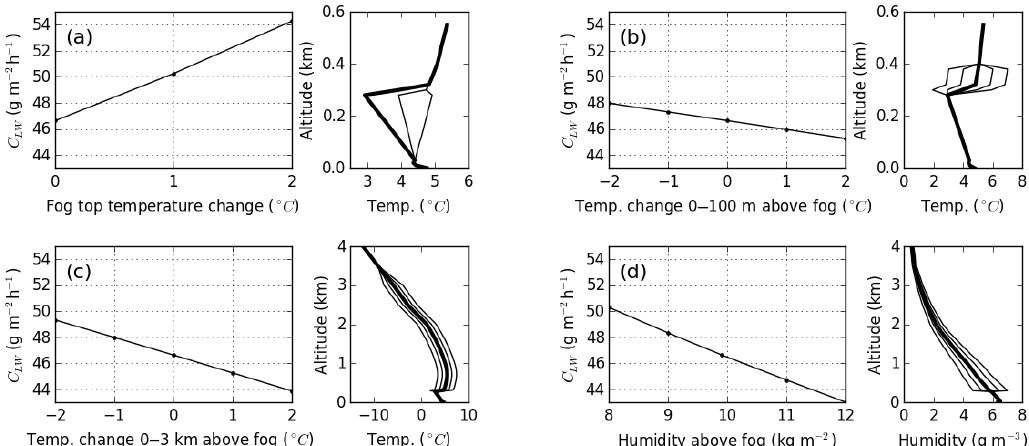
Figure 9. Sensitivity of C LW (defined in Sect. 2.1) to changing the fog top temperature (a) , the temperature in the first 100m above the fog (b) , the temperature in the first 3km above the fog (c) and the humidity above the fog (d) . All other input data are kept constant at the values for 13 December 2015 at 10UTC: the fog is 290m thick with no clouds above and a visible optical depth of 16.4. To the right of each result is a plot showing how the profile of temperature or humidity is modified from the original profile (thick